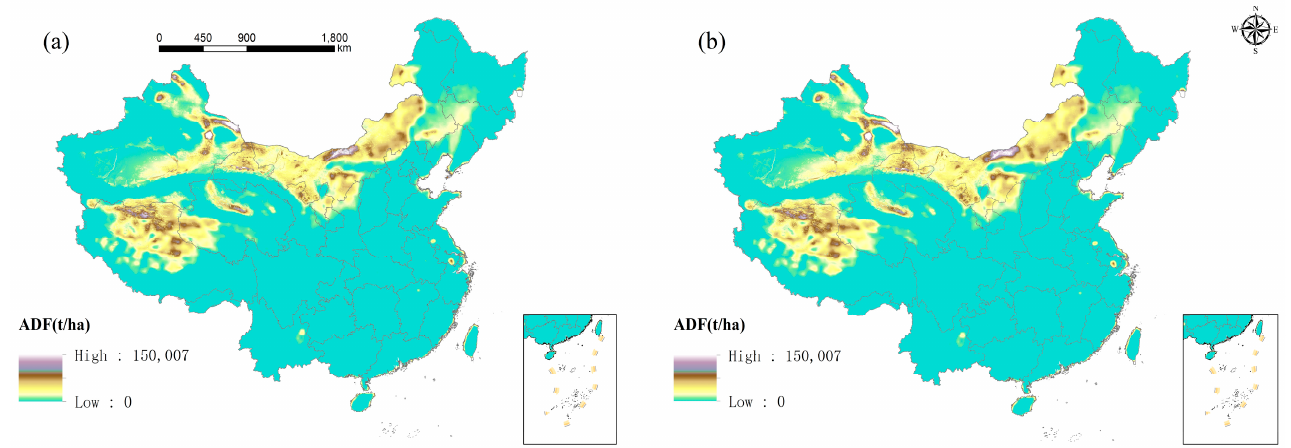
Figure 5. Temporal and spatial evolution of windbreak and sand fixation in China. ( a ) Windbreak and sand fixation in 2005 ; ( b ) Windbreak and sand fixation in 2020.